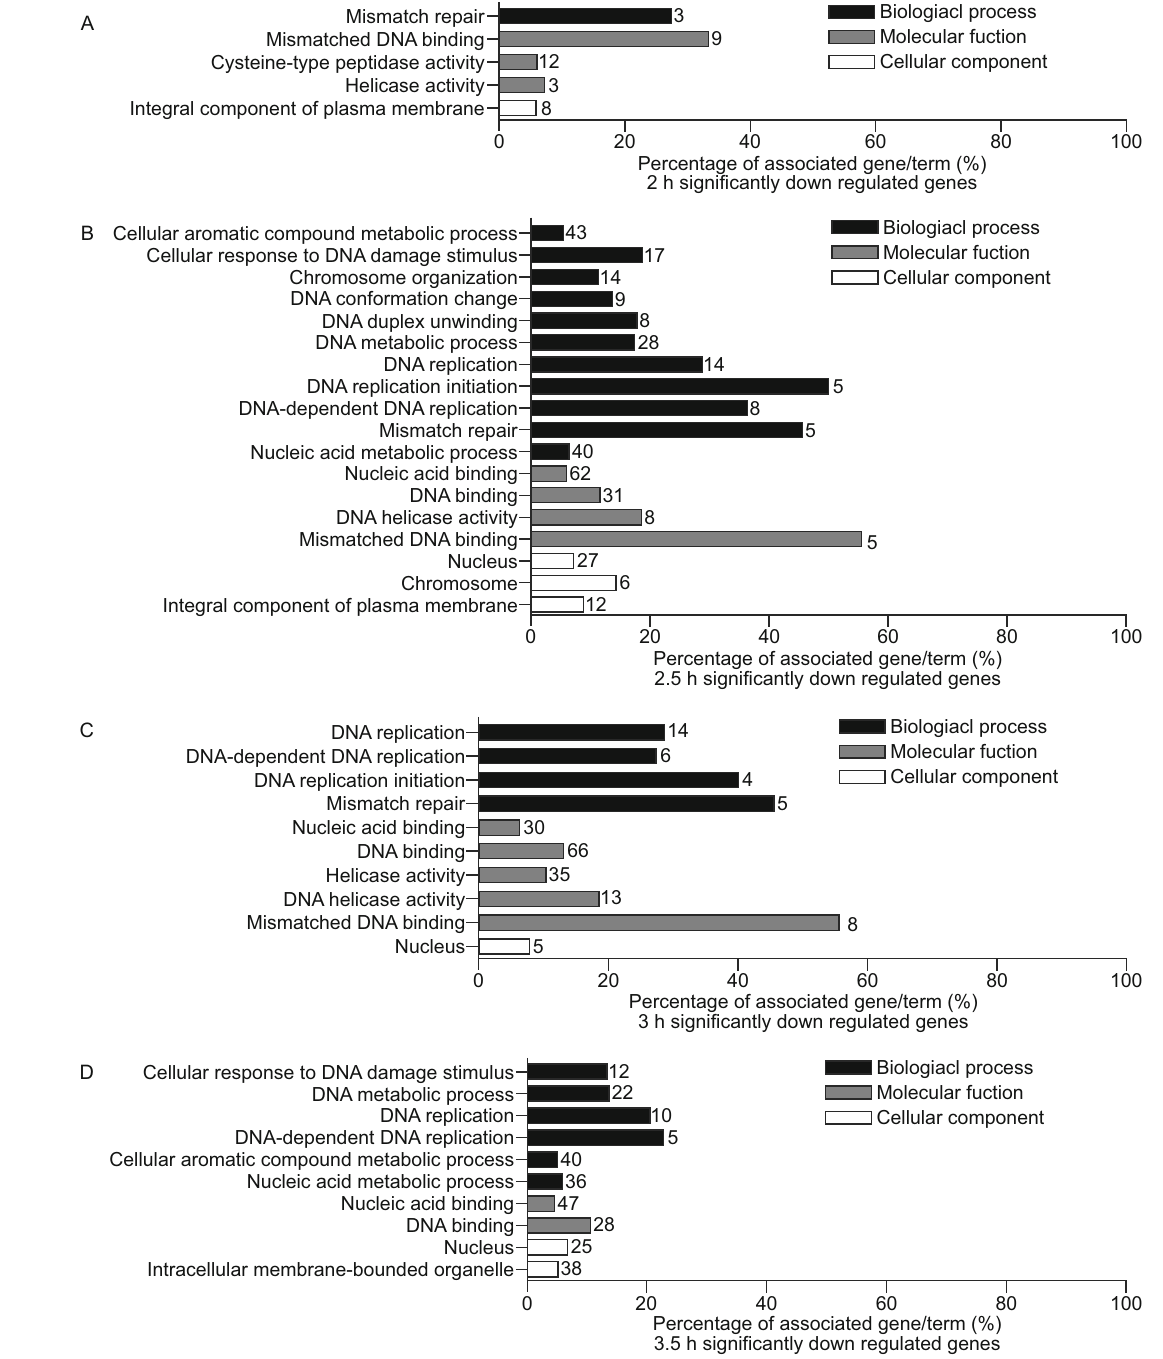
Figure 4. Gene ontology (GO) enrichment analysis of down regulated genes. The fi ltered signi fi cantly down regulated genes (Log2 (fold change) < − 2 and P value < 0.05) of each time point were subjected to GO enrichment analysis separately in biological process, molecular biology, and cellular function. (A) Percentage of associated genes/term (%) at 2 h. (B) Percentage of associated genes/term (%) at 2.5 h. (C) Percentage of associated genes/term (%) at 3 h. (D) Percentage of associated genes/term (%) at 3.5 h. The length of bars from each histogram indicates the percentage of associated genes for each term. The number on top of each bar means the number of associated